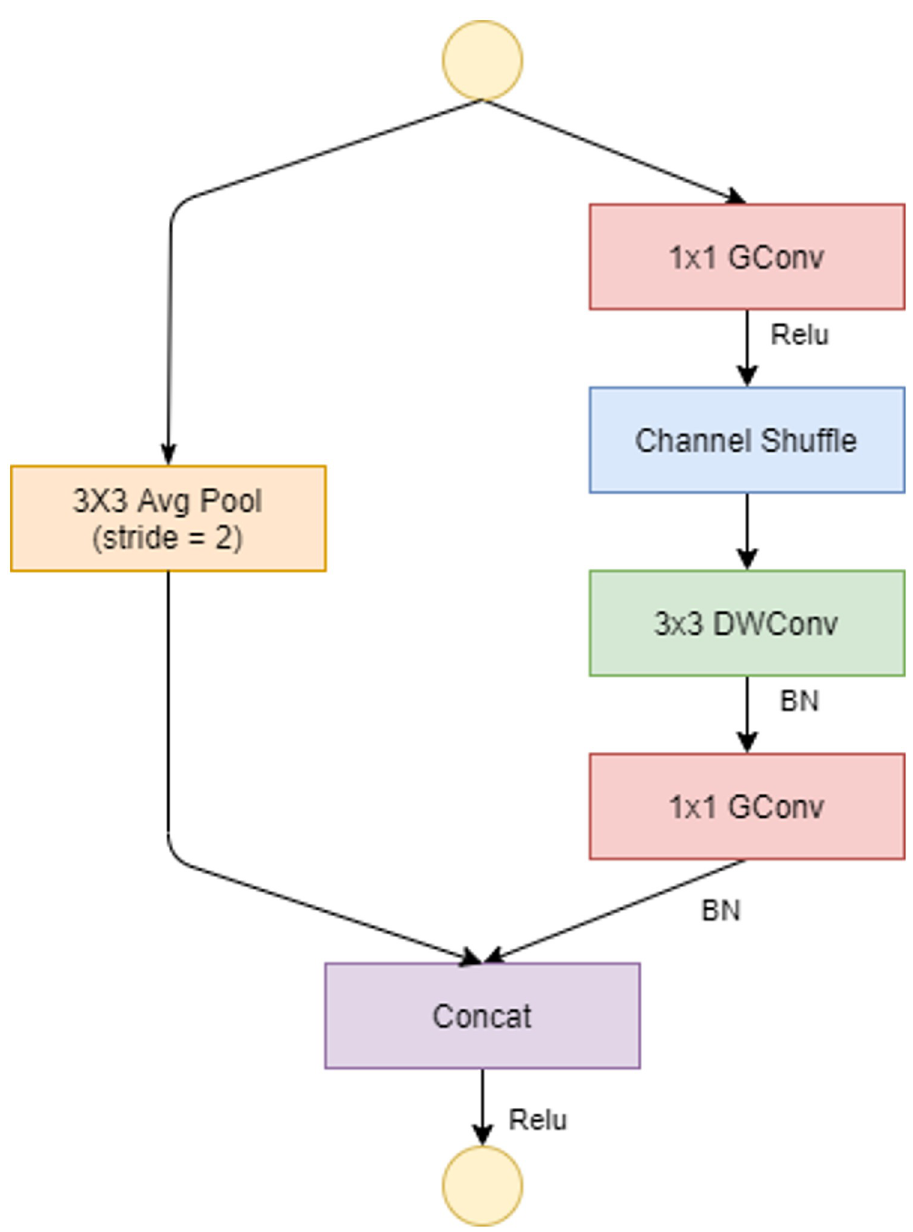
Fig 3. ShuffleNet unit with stride = 1. The activation functions used are Relu and Batch normalization